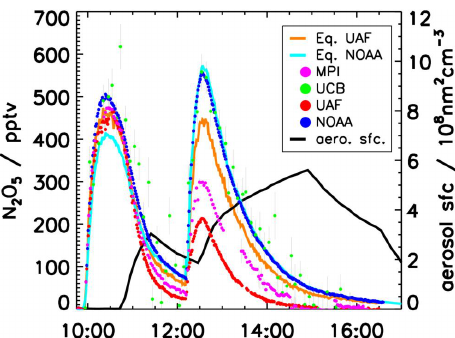
assuming thermal equilibrium between NO 3 and N 2 O 5 on 15 June when ammonium sulfate aerosol was injected into the chamber. N 2 O 5 was either calculated from NO 3 measurements from the UAF-CRDS or NOAA-CRDS